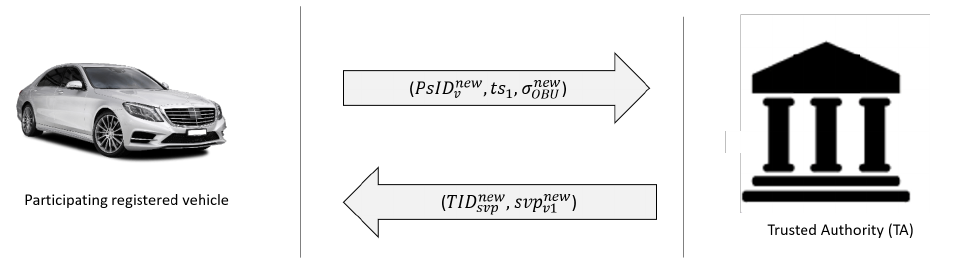
Figure 3. Update vehicle true identity